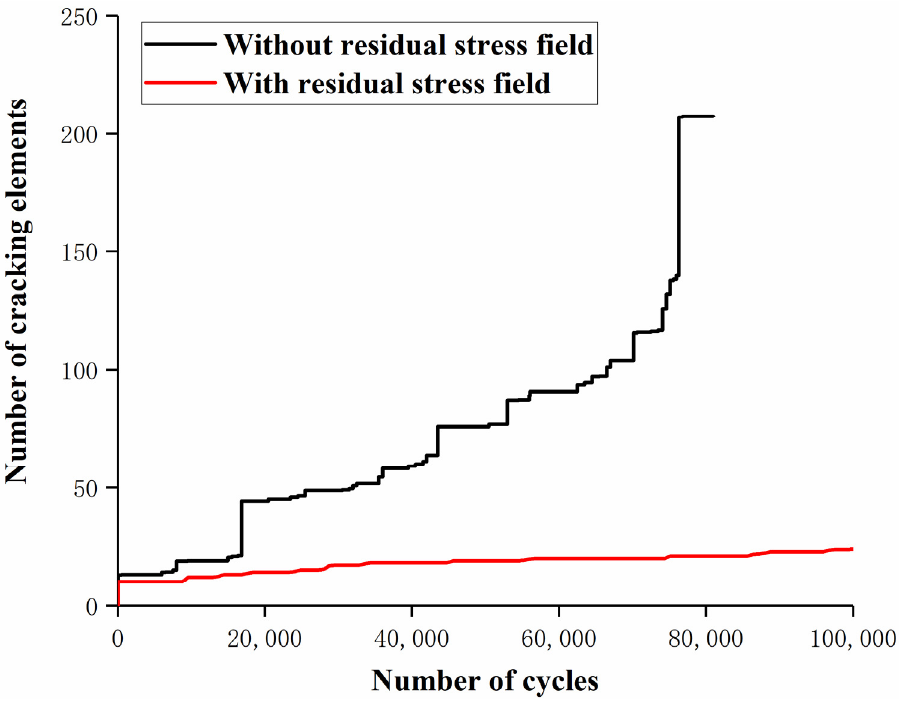
Figure 25. Crack expansion rate when the initial crack is located at the start of the weld.